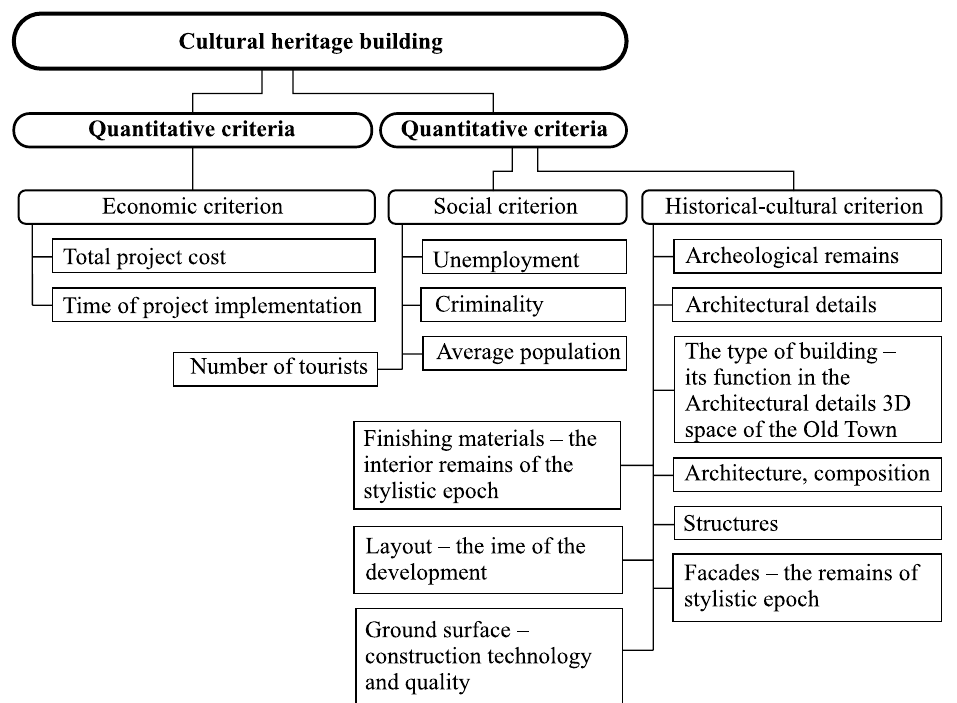
fig. 1. Quantitative and qualitative criteria and subcriteria used in describing cultural heritage